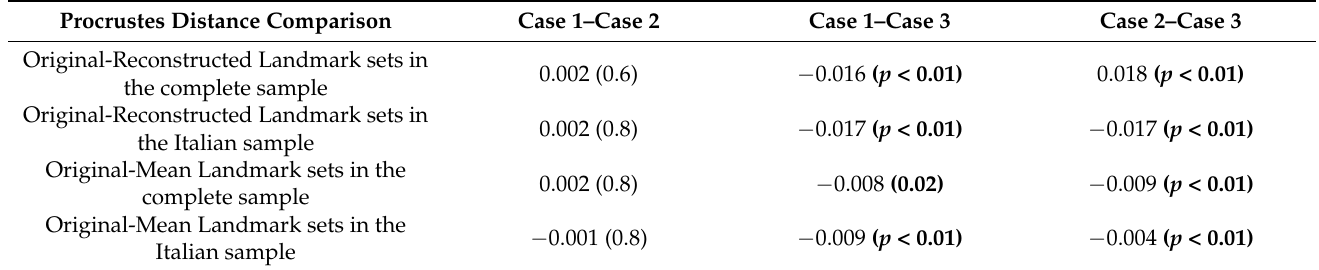
Table 3. ANOVA post hoc pairwise comparisons (Tukey’s HSD) of the Procrustes distance between the original and the reconstructed landmark configuration and between the original and mean landmark configuration in Cases 1, 2 and 3. p -values are in parentheses. Significant results are given in